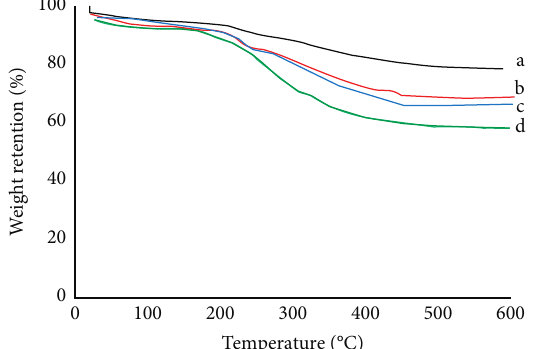
Figure 7: Thermogravimetric analysis (TGA) of (a) MSN-Cys, (b) MB@MSN-Cys at pH 1.5 and 150ppm, (c) MB@MSN-Cys at pH 7 and 150ppm, and (d) MB@MSN-Cys at pH 8.5 and Table 2: Comparison of removal of MB by different functional groups on mesoporous silica surfaces. Functional group